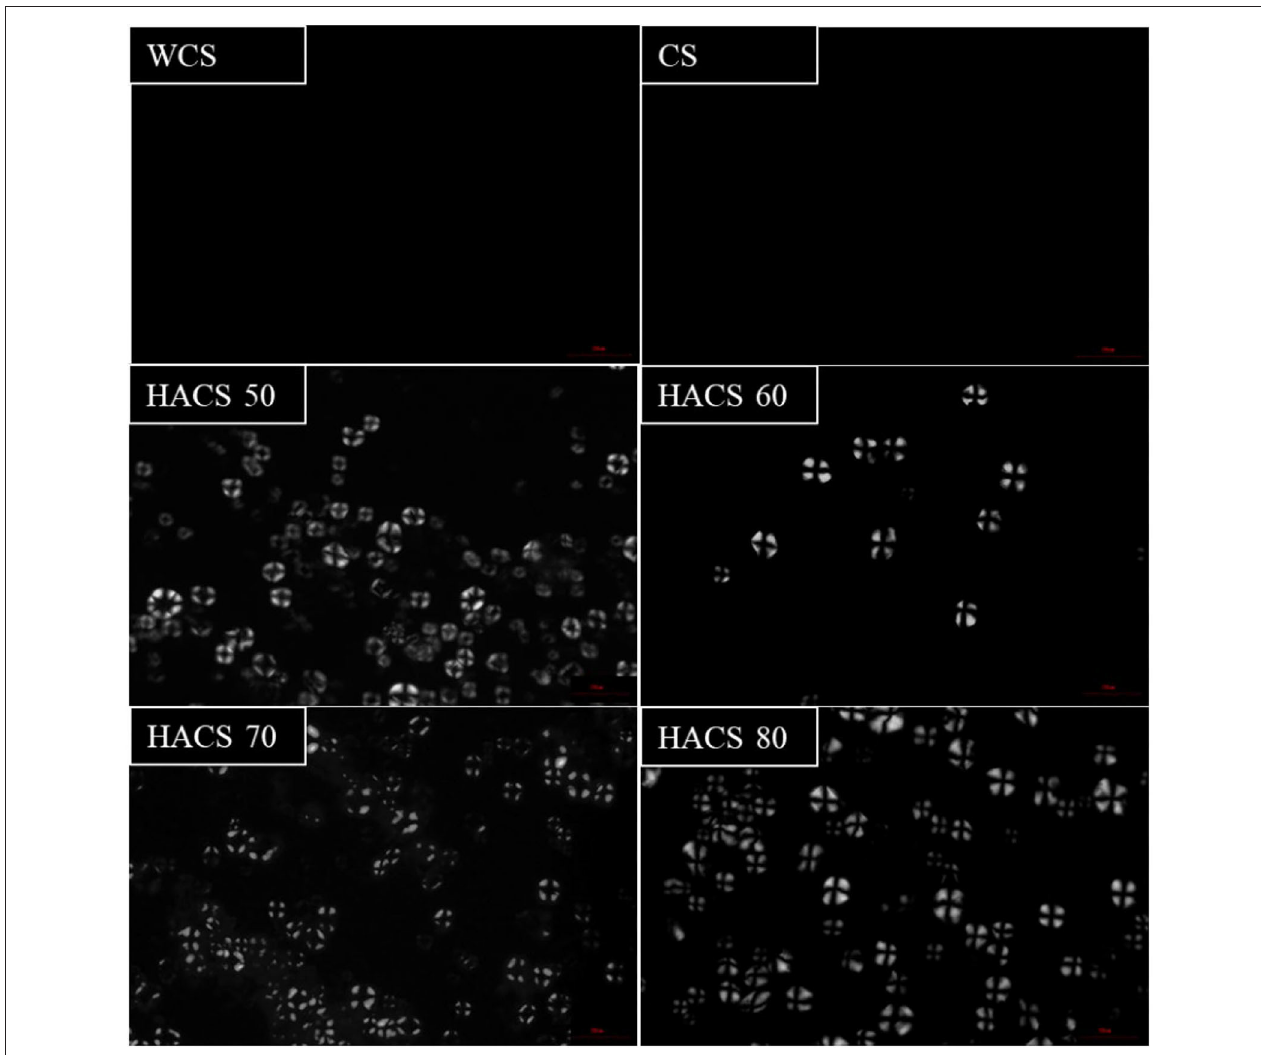
FIGURE 2 | The cross-polarization of corn starch with different amylose content after gelatinization.